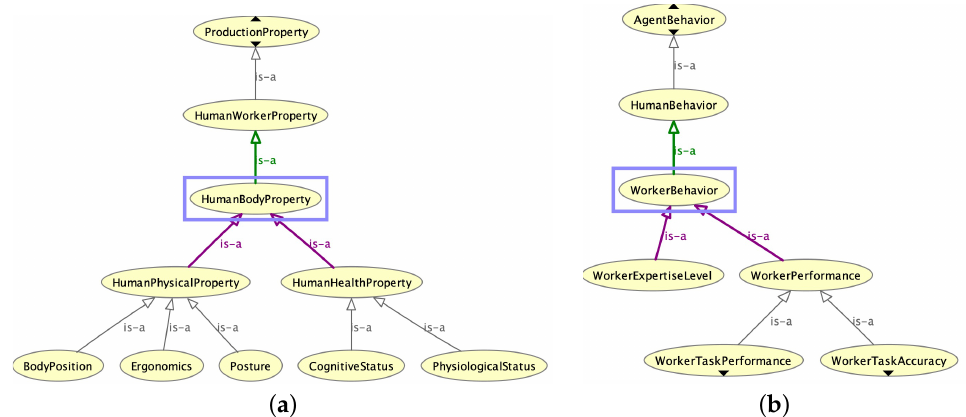
Figure 4. Excerpt of SOHO concerning the variables of the user model: ( a ) it shows concepts modeling qualities associated with the physical body of a worker; ( b ) it shows concepts modeling the qualities associated with the behavior of a